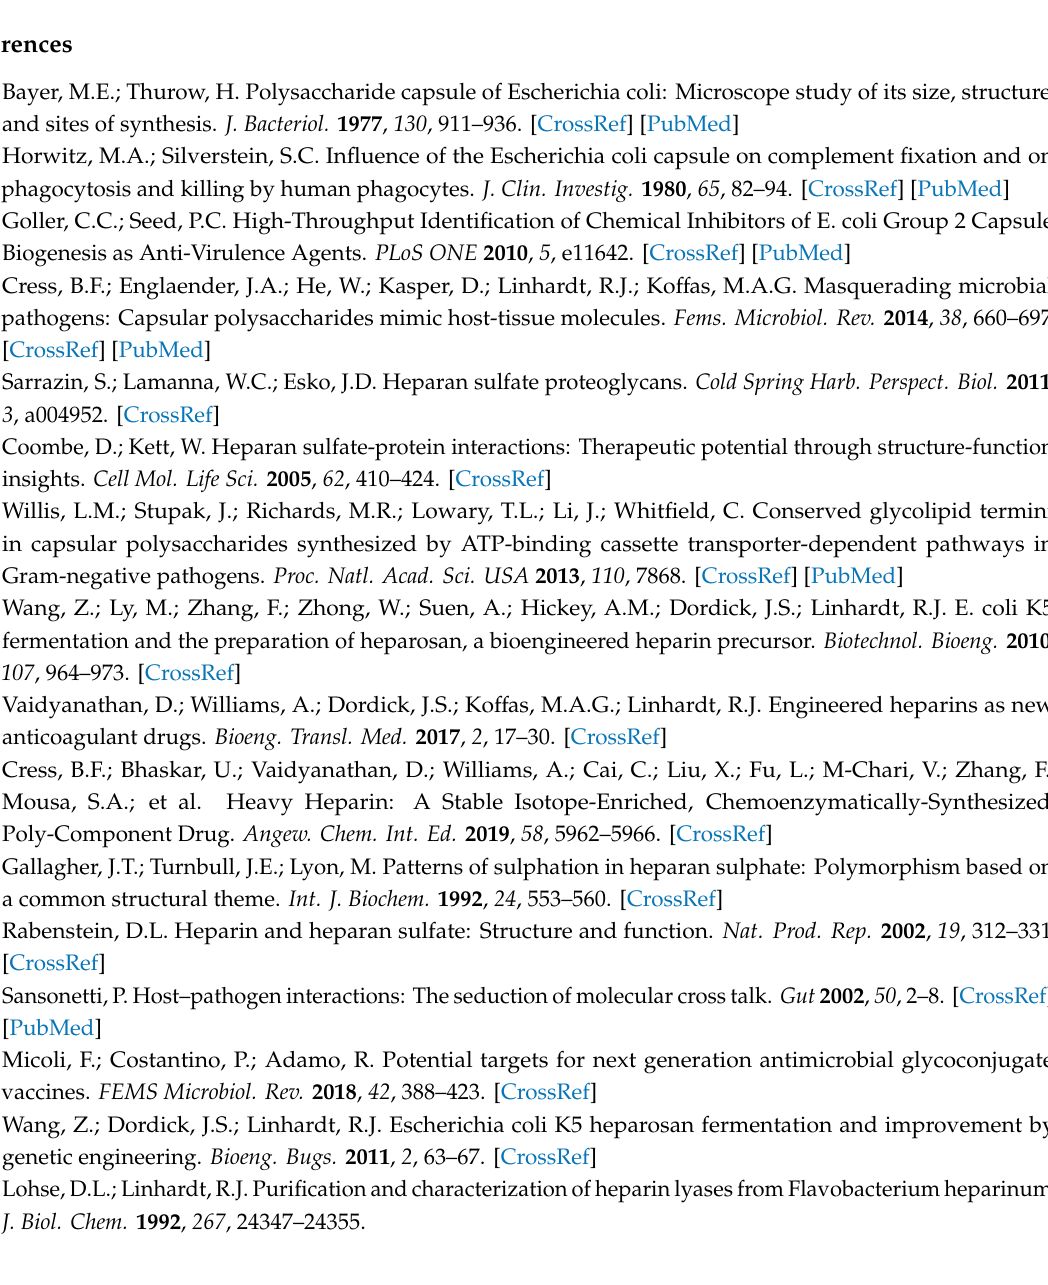
Figure S1: High performance gel permeation chromatography (HPGPC) profiles of partially digested heparosan by heparin lyase III, Figure S2: Mass spectrum of fatty acids hydrolyzed from resistant fraction 2 by phospholipase A1 and A2, Figure S3: (A) COSY NMR spectrum of the resistant fraction 1. (B) TOCSY NMR spectrum of the resistant fraction 1. (C) HSQC NMR spectrum of the resistant fraction